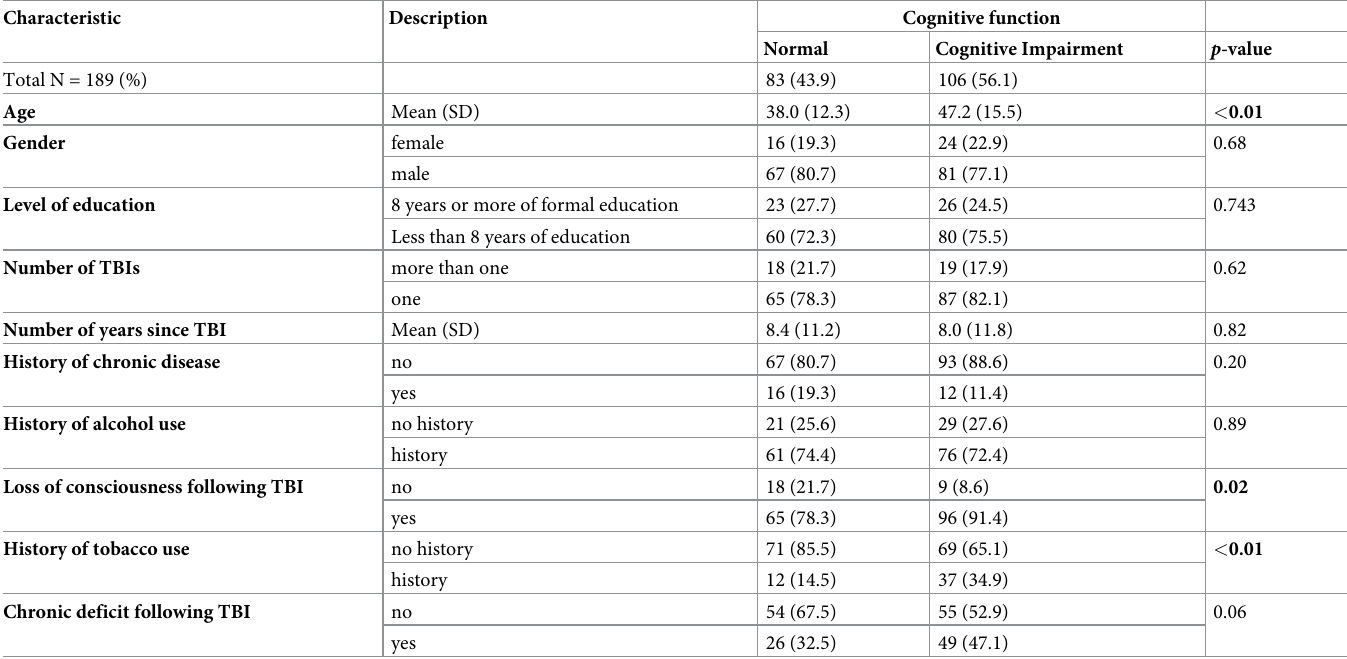
Table 2. Results from chi-square analysis and T-test showing association between the participants’ characteristics and cognitive impairment. Characteristic